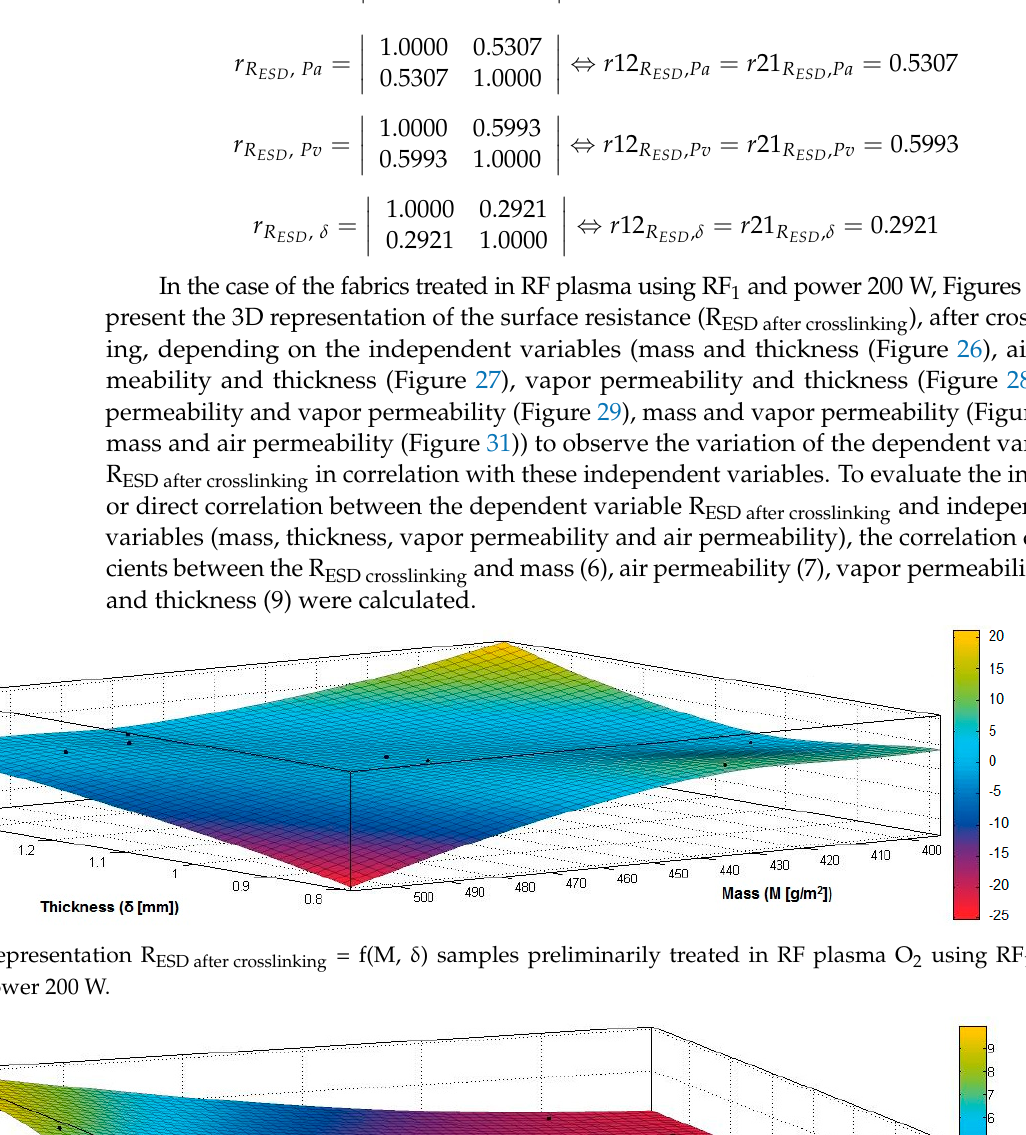
Figure 27. 3D representation R ESD after crosslinking = f(Pa, δ ) samples preliminarily treated in RF plasma O 2 using RF 1 generator and power 200 W.